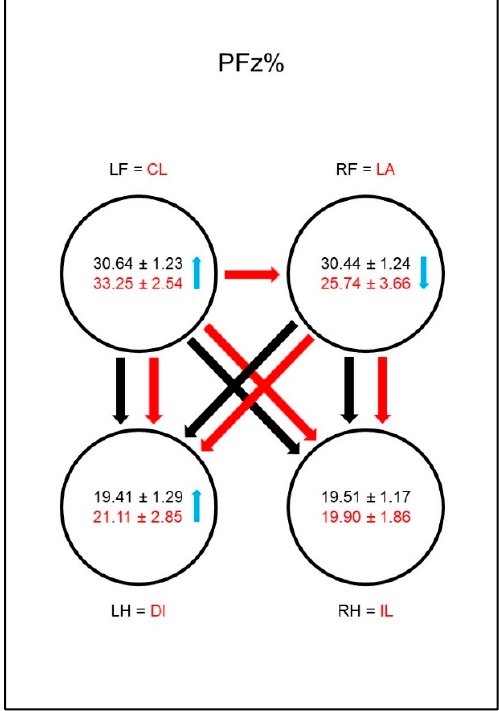
Figure 11. Peak vertical force as a percentage of total force (PFz%) in study group 2 and control group. For detailed explanation and abbreviations refer to Figure 2.